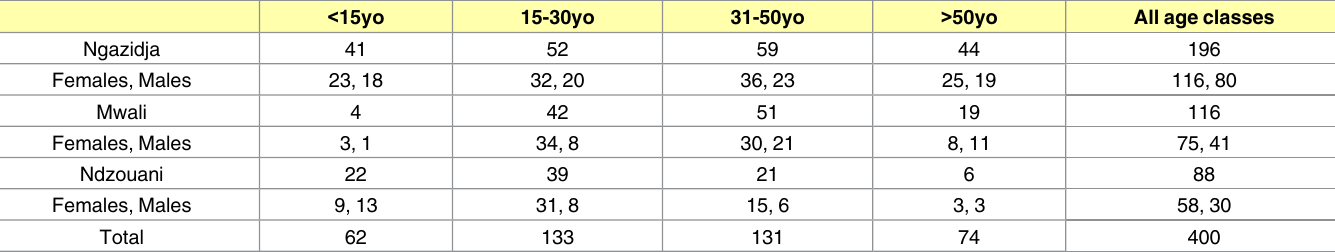
Table 1. Distribution of the study sample according to gender, age class and island.